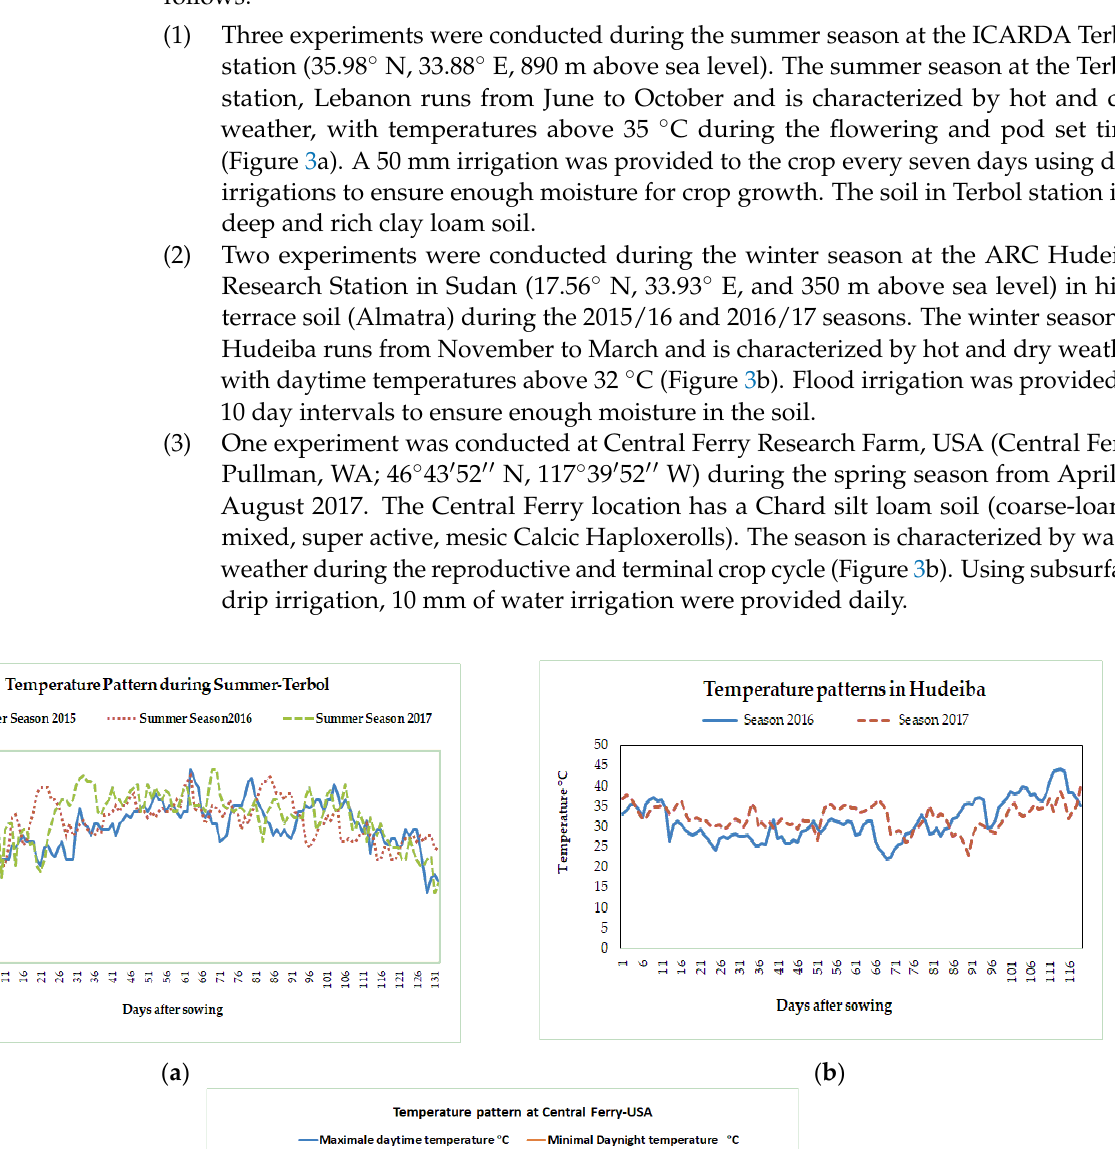
Table 9. Details of experiments conducted in different locations.